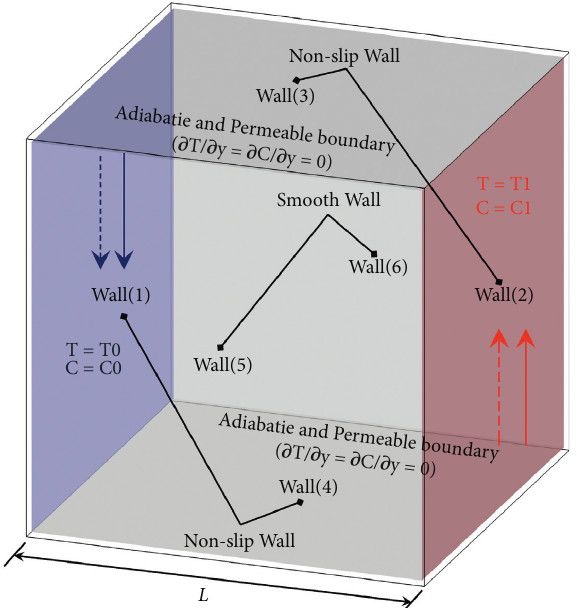
Figure 2: Schematic diagram of double-diffusive natural con- vection in a cubic